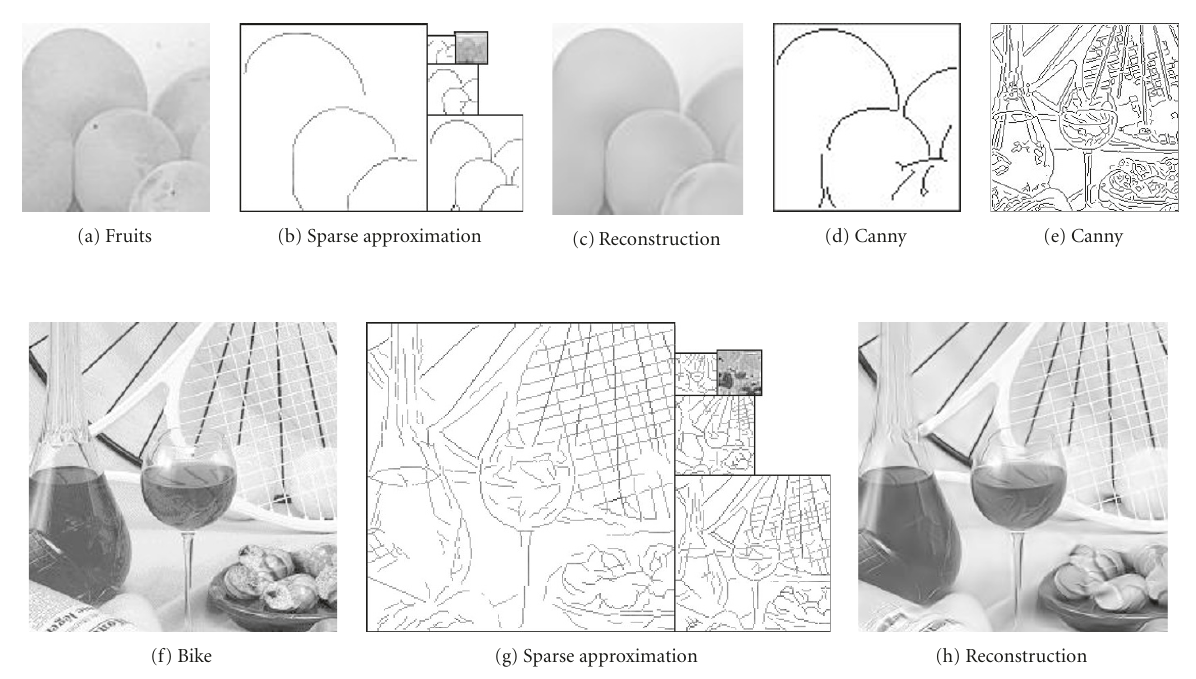
Figure 7: Extraction of multiscale edges and reconstruction. (a) 96 × 96 pixels tile of the image “Fruits.” (f) 224 × 224 pixels tile of the image “Bike.” (b), (g) Edges extracted by the proposed model. The gray level indicates the amplitude of the edges given by the gain control mechanism. (c), (h) Reconstruction from edges. (d), (e) Edges extracted by Canny method.